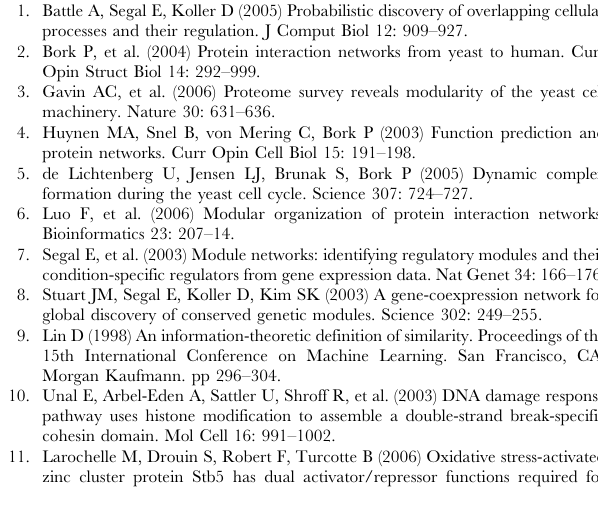
Figure S1 A) The yeast PPI-subnetwork consisting of only those genes that are annotated with ‘‘regulation of MAPK activity’’ (yellow nodes) or ‘‘hyperosmotic response’’ (black nodes), and their neighbors. B,C) In order to test whether there is an edge linking term t1 to term t2, one needs to consider the genes that are annotated with t1 (green nodes), those of their neighbors that are not annotated with t1 (blue nodes), the genes that are annotated with t2 but are not annotated with t1 (red nodes) and the intersection of the latter two (purple nodes). B) The test for an edge linking ‘‘hyperosmotic response’’ to ‘‘regulation of MAPK activity’’ is positive. C) The test for an edge linking ‘‘regulation of MAPK activity’’ to ‘‘hyperosmotic response’’ is negative. Figure S2 Complementary Cumulative Distribution of the in- and out-degrees in the PLN obtained for yeast. A) In-degree; B) Out-degree. Figure S3 Venn diagram representation of the sizes of the intersections between the sets of pairs of PPI-linked, expression- linked and GI-linked processes. Each set contains only linkages between processes that appear in all three types of linkage